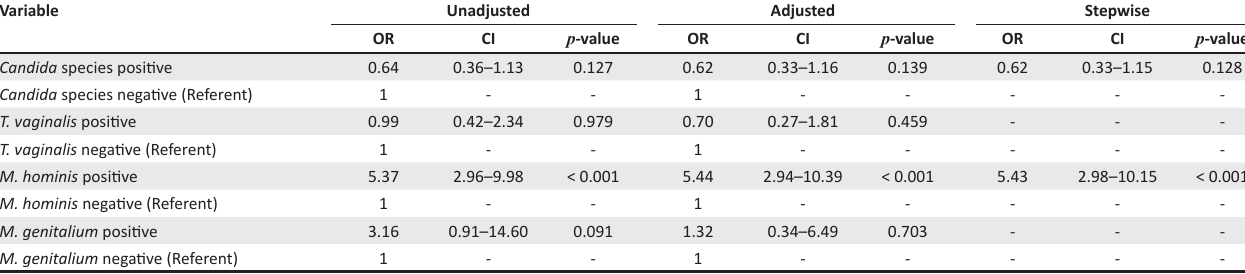
TABLE 5: Risk of acquiring bacterial vaginosis in the presence of other genital infections. Variable